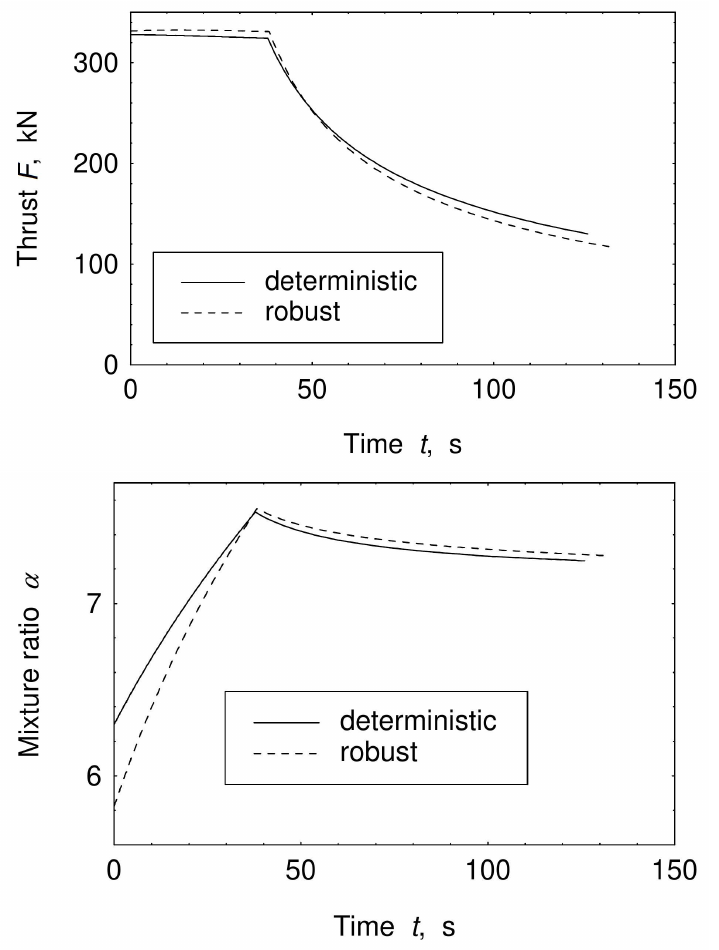
Figure 7. Trust and mixture ratio histories for the deterministic and robust optimal design (2 uncertain